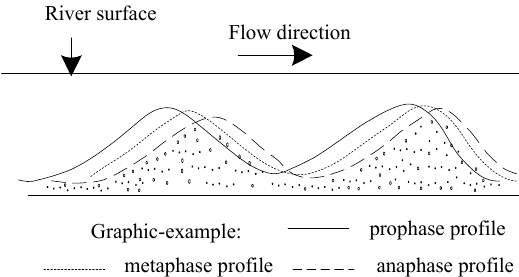
Figure 1. Sketch of the migration of sand waves.